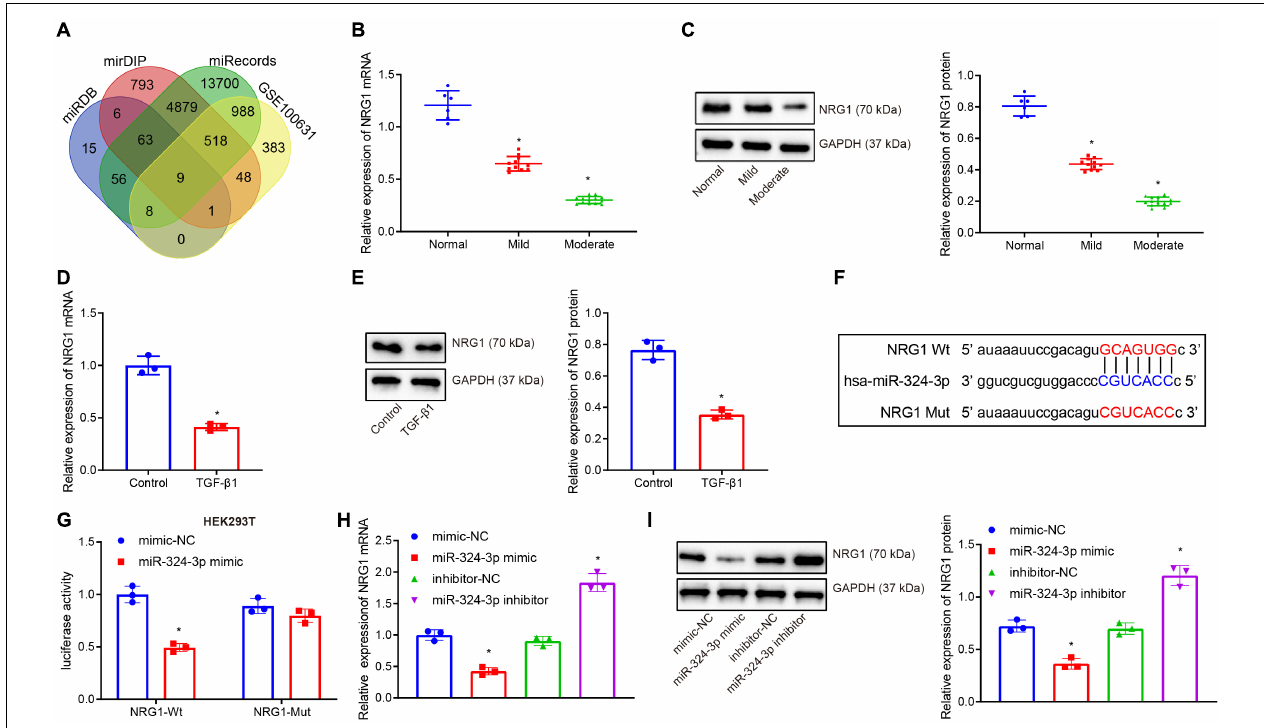
FIGURE 2 | miR-324-3p targets and negatively regulates NRG1. (A) Venn diagram of the target genes of miR-324-3p in miRDB, mirDIP, and miRecords databases; (B) RT-qPCR results of NRG1 mRNA expression in 30 renal tissue samples; (C) Western blot results of NRG1 protein expression in 30 renal tissue samples; (D) RT-qPCR results of NRG1 mRNA expression in HK-2 cells exposed to TGF- β 1; (E) Western blot results of NRG1 protein expression in HK-2 cells exposed to TGF- β 1; (F) online prediction of the binding site of miR-324-3p and NRG1 mRNA 3 (cid:48) UTR; (G) targeting relationship between miR-324-3p and NRG1 by dual-luciferase reporter gene assay; (H) RT-qPCR results of the NRG1 mRNA expression after miR-324-3p overexpression or silencing; (I) Western blot results of the NRG1 protein expression after miR-324-3p overexpression or silencing. * p < 0.05 as compared with normal, control, mimic-NC, or inhibitor-NC. The measurement data were expressed as mean ± standard deviation. Data between the two groups were compared using the unpaired t- test. One-way ANOVA was used for data comparisons among multiple groups, followed by Tukey’s post hoc test. The cell experiments were repeated three times independently.